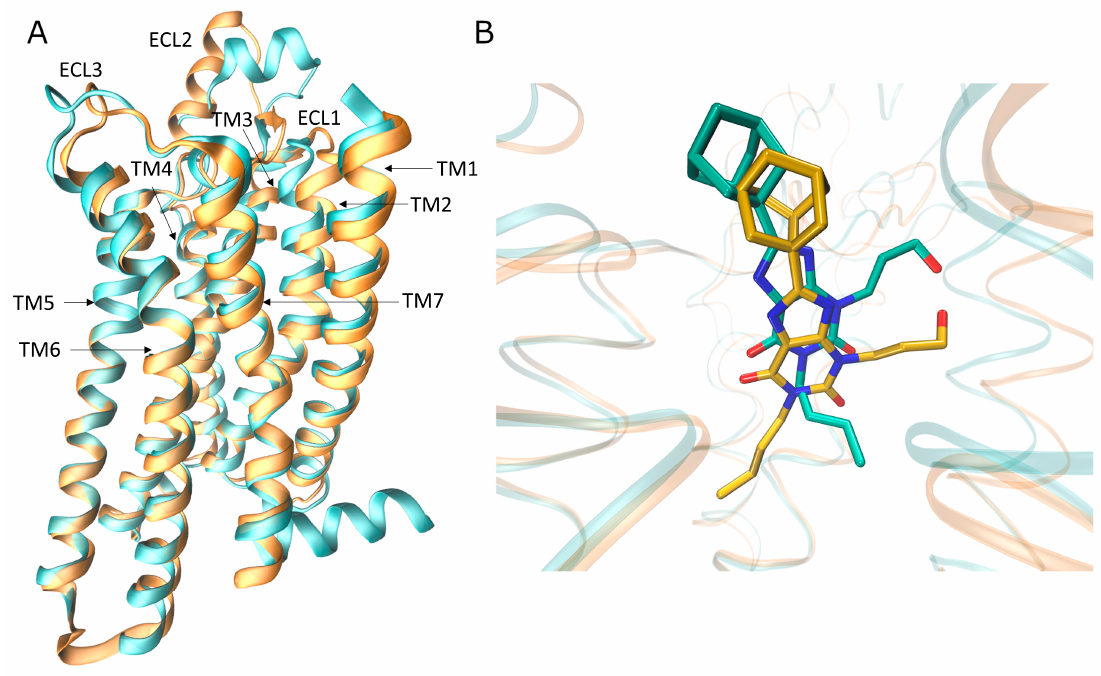
Figure 1. Comparison of A 1 ARand A 2A AR structures ( A ) Superposition of the crystal structure of the inactive A 1 (orange) and A 2A (cyan) adenosine receptors (Ars) (PDB code 5N2S and 5N2R respectively). ( B ) Superposition of the same xanthine ligand PSB36 in the two aforementioned crystal structures.